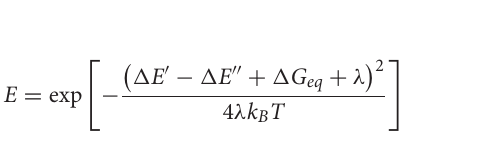
Frontiers in Energy Research |